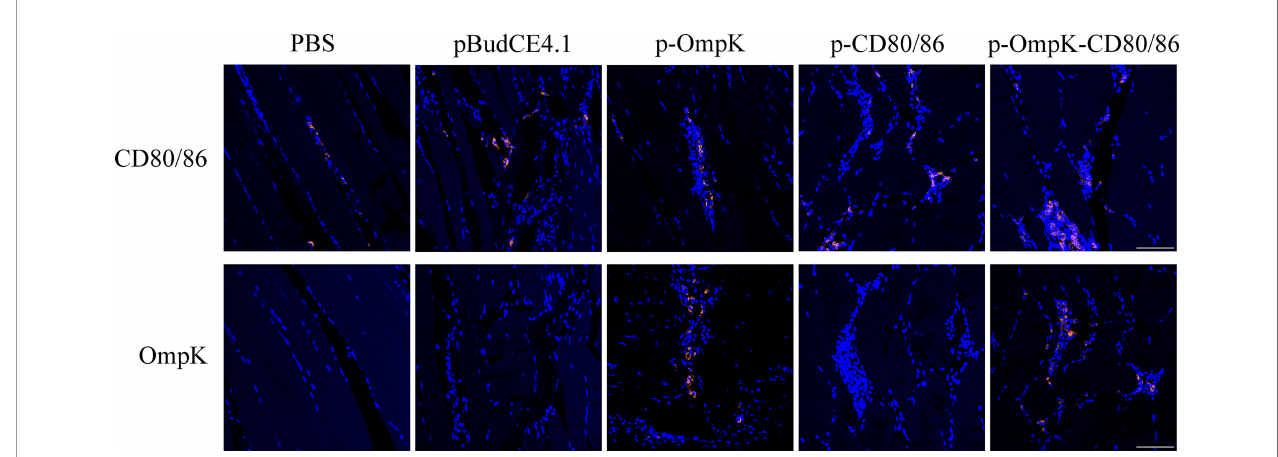
FIGURE 6 | Expression of OmpK and CD80/86 in the muscle of fl ounder was detected by indirect immuno fl uorescence on the 7th day after immunization. The muscle from PBS, pBudCE4.1, p-CD80/86, p-OmpK, and p-OmpK-CD80/86 was incubated with rabbit anti-CD80/86 or anti-OmpK antibodies. DAPI staining shows cell nuclei, and the red fl uorescence indicated the positive signals of OmpK or CD80/86. Sections from the PBS group were used as the negative control. IIF was analyzed by epi fl uorescence microscopy at a magni fi cation of 20×. Scale bar = 50 m